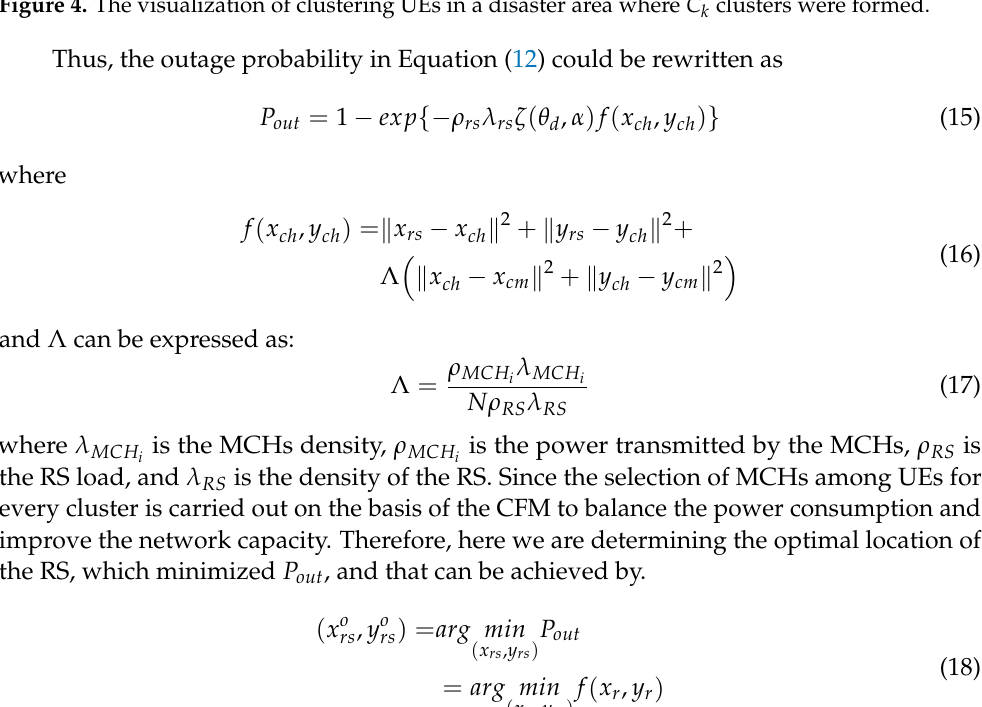
Figure 4. The visualization of clustering UEs in a disaster area where C k clusters were